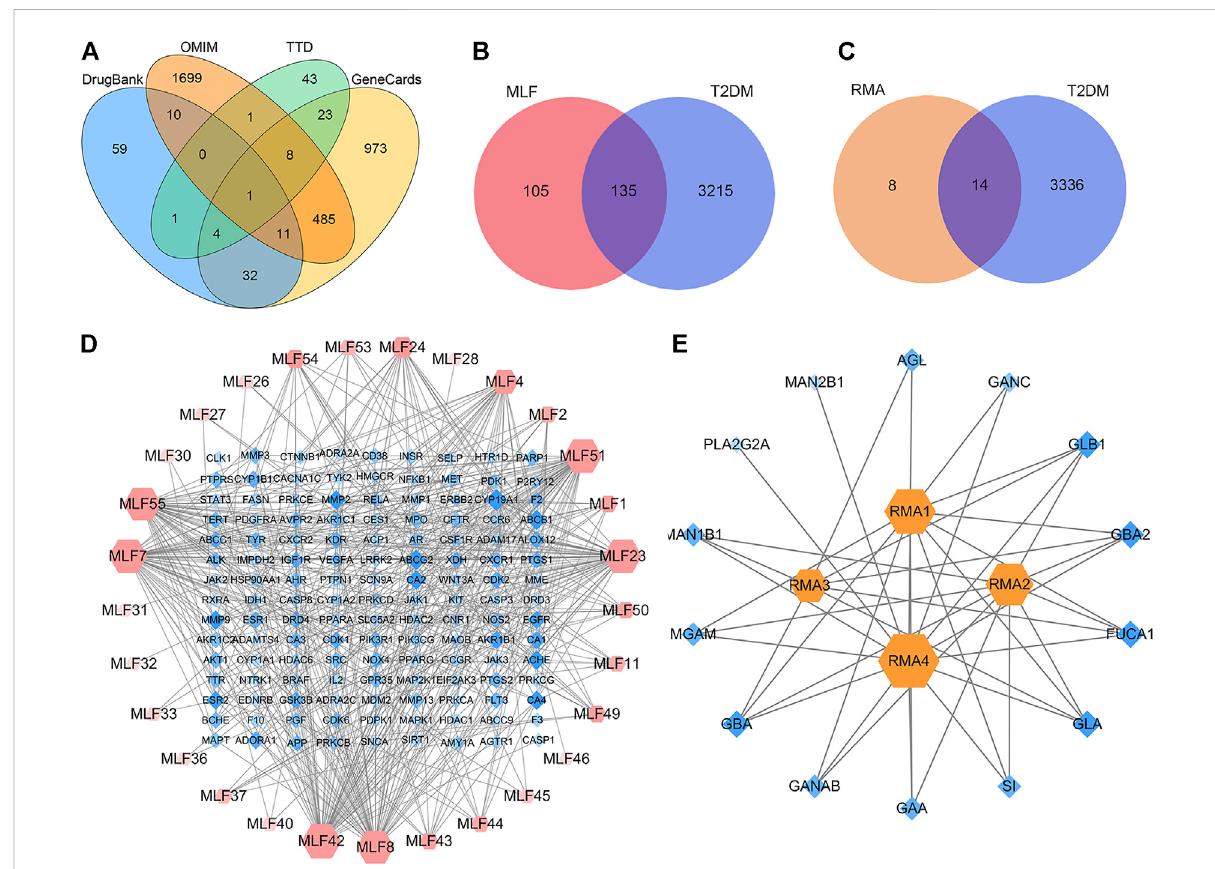
FIGURE 5 Target or active compound prediction and network construction. (A) Putative targets for T2DM were retrieved from the Drugbank, OMIM, TTD and GeneCards databases. (B) The 135 matched targets common between the predicted mulberry leaf fl avonoid targets and the type 2 diabetes targets. (C) The 14 matched targets common between the predicted Ramulus Mori alkaloid targets and the type 2 diabetes targets. (D) The compound-target network implicated in type 2 diabetes using mulberry leaf fl avonoids. The red nodes represent the active mulberry leaf fl avonoids,whereasthebluenodesrepresenttheantidiabetictargetsoftheactivecompounds. (E) Thecompound-targetnetworkimplicatedintype 2 diabetes using the Ramulus Mori alkaloids. The orange nodes represent the active Ramulus Mori alkaloids, whereas the blue nodes represent the antidiabetic targets of the active compounds. The edges represent the interactions between compounds and targets, and the node size is proportional to the degree of